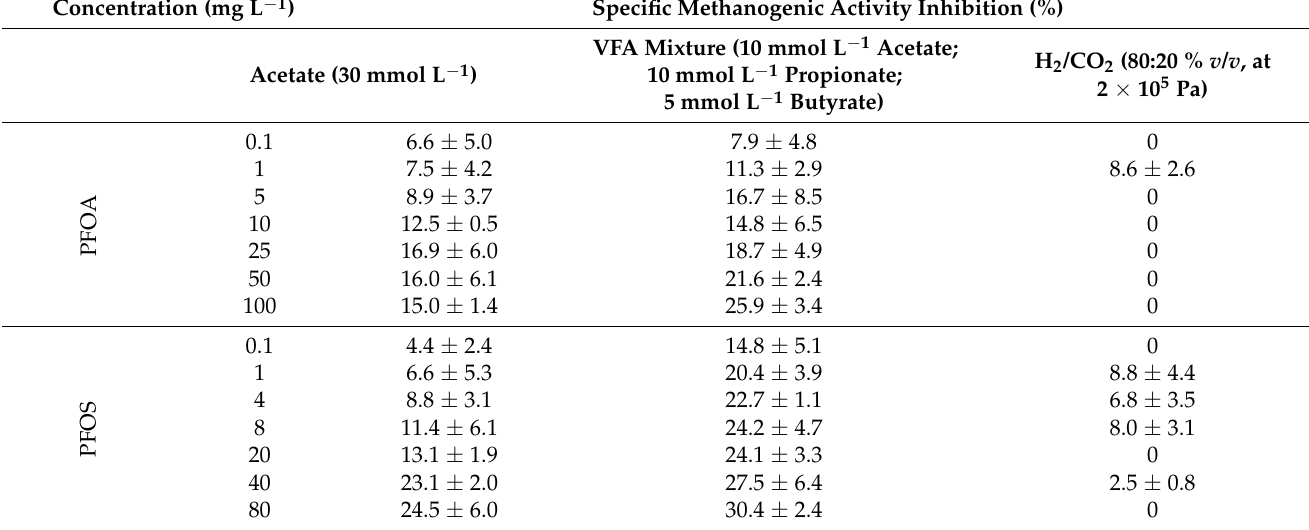
Table 1. Toxicity exerted by PFOA and PFOS towards methanogenic microorganisms in the presence of different